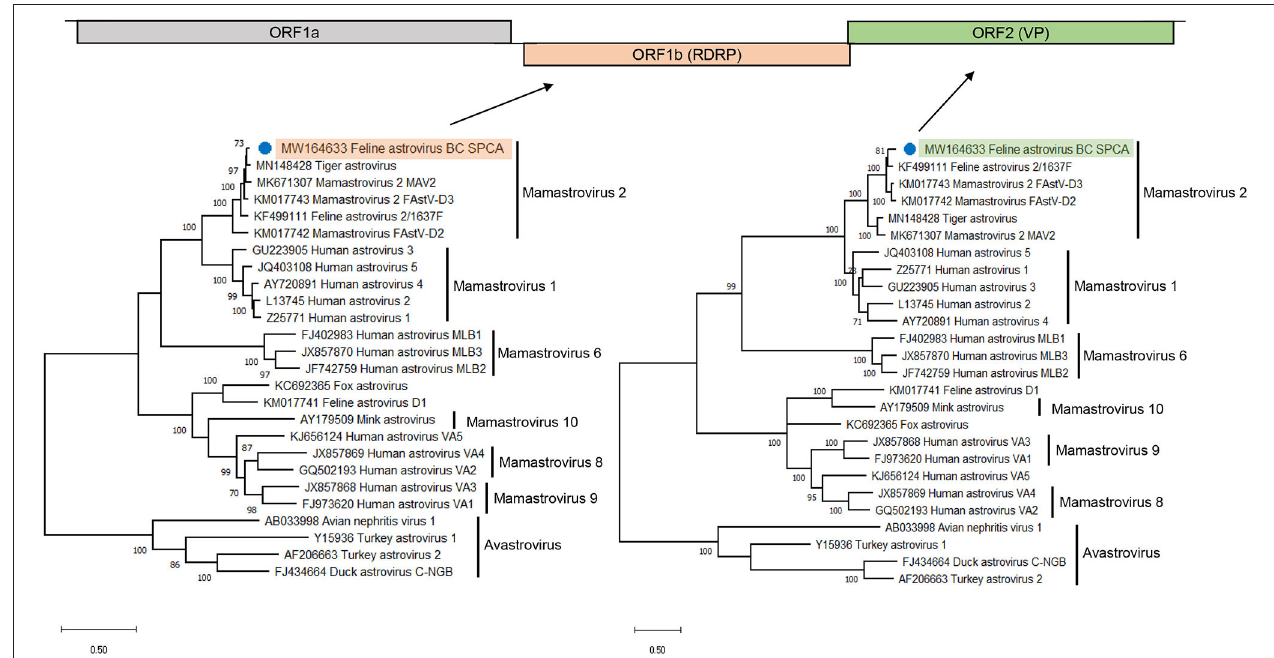
FIGURE 3 | Phylogenetic analysis of RdRp (left) and the capsid region (right) of feline astrovirus in a shelter outbreak. Phylogenetic trees were inferred by the maximum likelihood method based on nucleotide sequences. Related astrovirus from mamastrovirus were included for analysis. Astroviruses were used as the outgroup; the astrovirus detected in this study was highlighted. Branch length are scaled to the number of nucleotide substitutions per